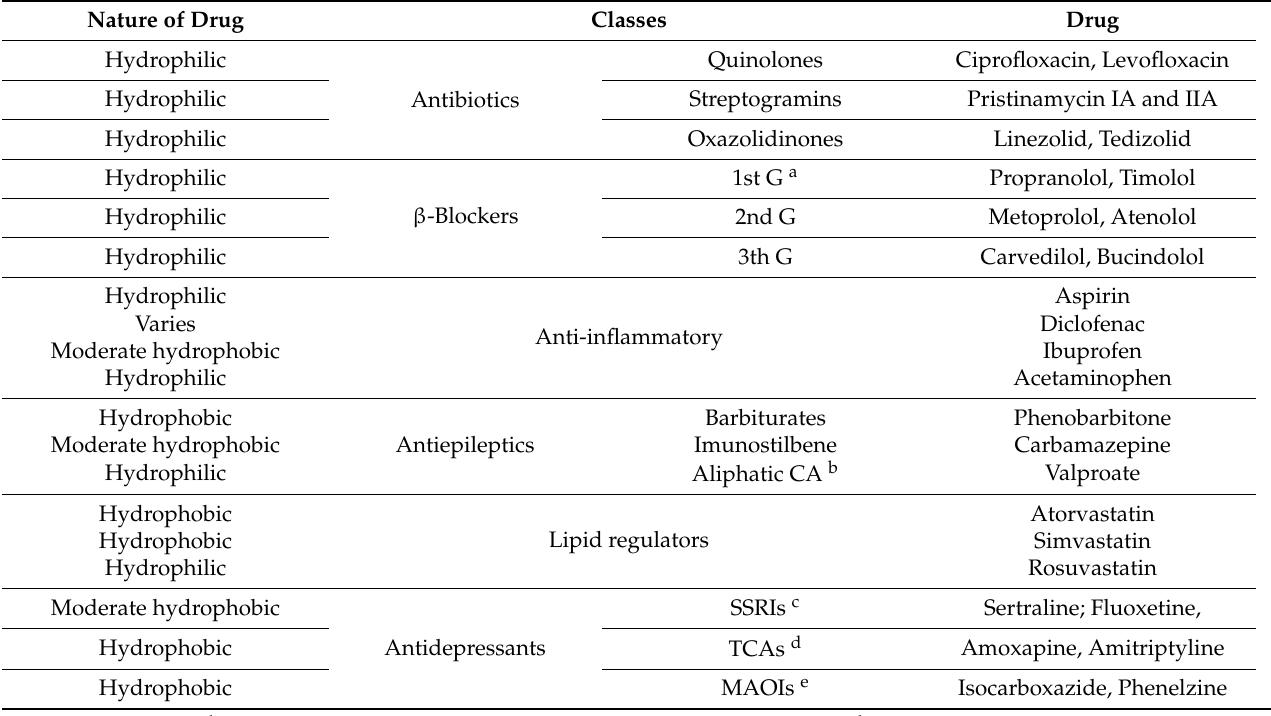
Table 1. Example of some classes and nature of